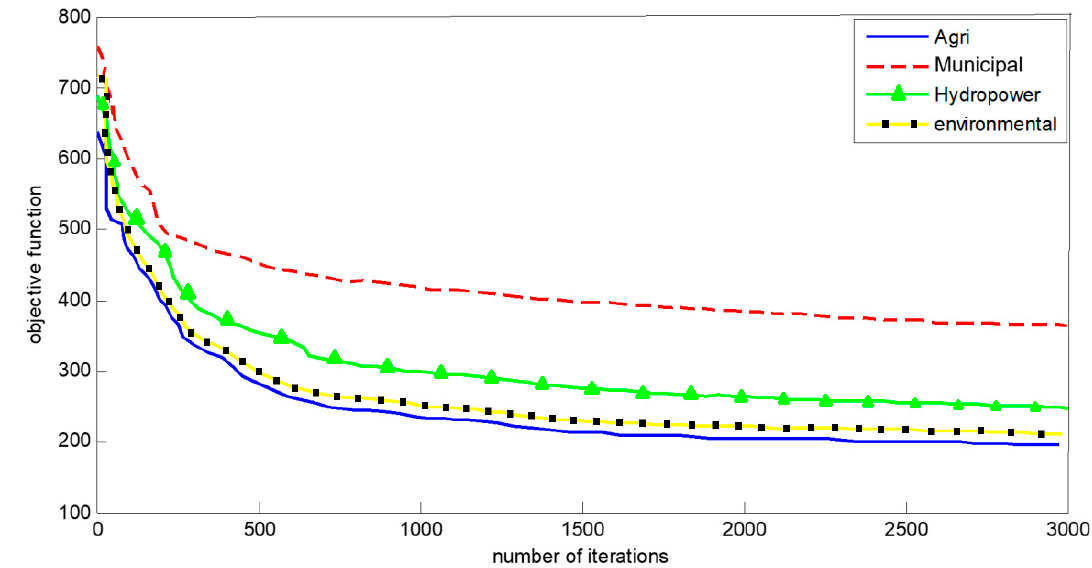
Figure 8. Convergence graph of the fuzzified discrete hedging rule. Table 3 shows the coefficients obtained in the calibration process for the hedging and fuzzy hedging methods for each reservoir. According to the table, the V (cid:2869)(cid:3017) coefficients for the fuzzified discrete hedging rule were less than the discrete hedging level for all months. As shown in Figure 1, the value of V (cid:2869)(cid:3017) indicates the starting point of the hedging, and the lower the value, more needs are fully met. The same is true for V (cid:2870)(cid:3017) . Moreover, α coefficients were generally higher with the fuzzified discrete hedging rule compared to the discrete hedging rule. Alpha coefficients are the percentages of the supply in hedging phases. Therefore, higher alpha values indicate lower hedging intensity. Table 3. Discrete hedging and fuzzified discrete hedging coefficients.